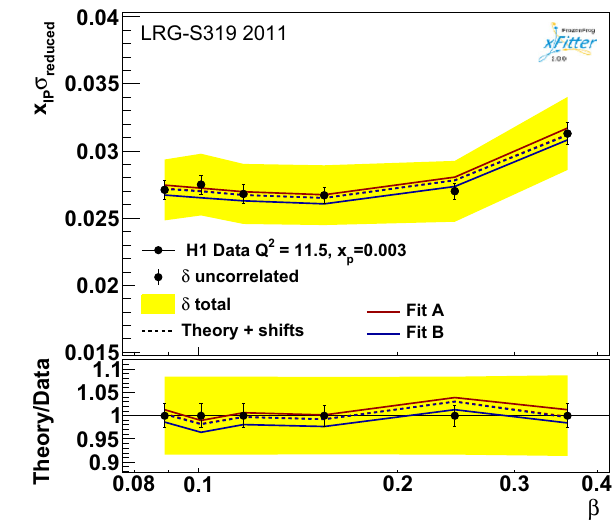
√ s = 225 (left) and 319 (right). The error bars on 2011 data [42,43] at the data points represent the uncorrelated uncertainties and the yellow bands represent the total uncorrelated and correlated